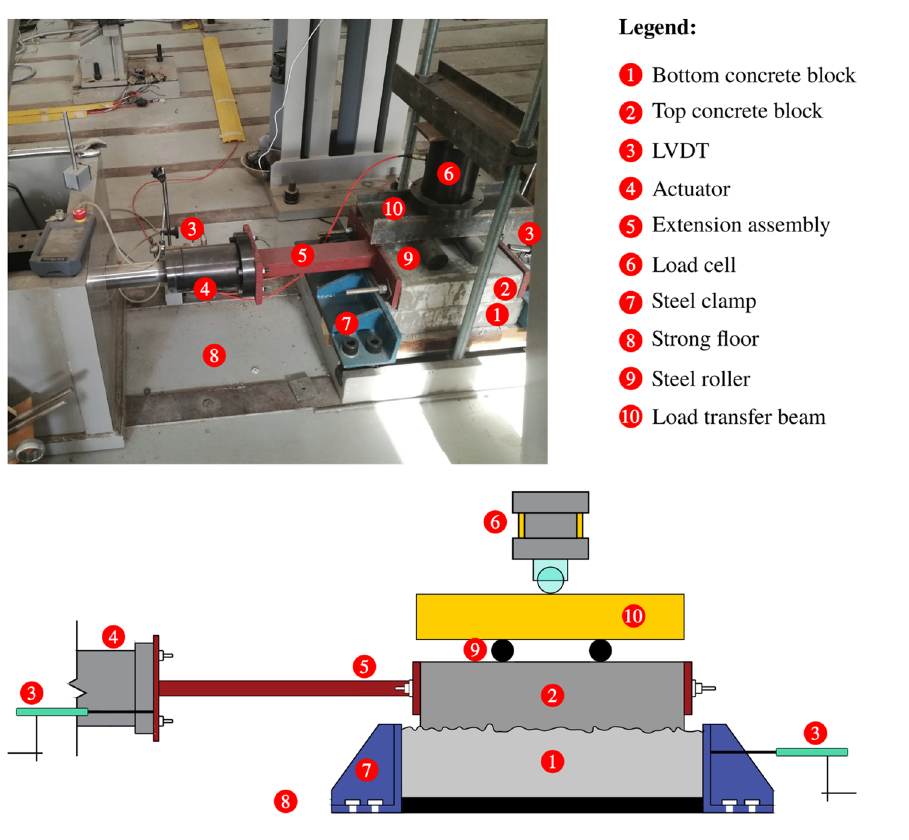
Figure 4. Test Setup and